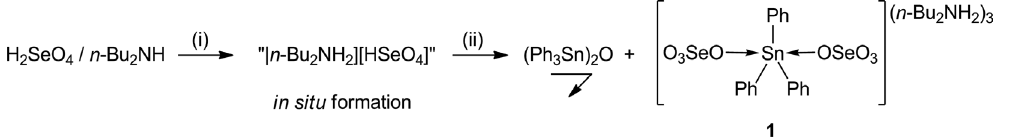
Figure 1 Molecular structure of [ n -Bu showing 30% probability ellipsoids and the crystallographic num- bering scheme (Ortep